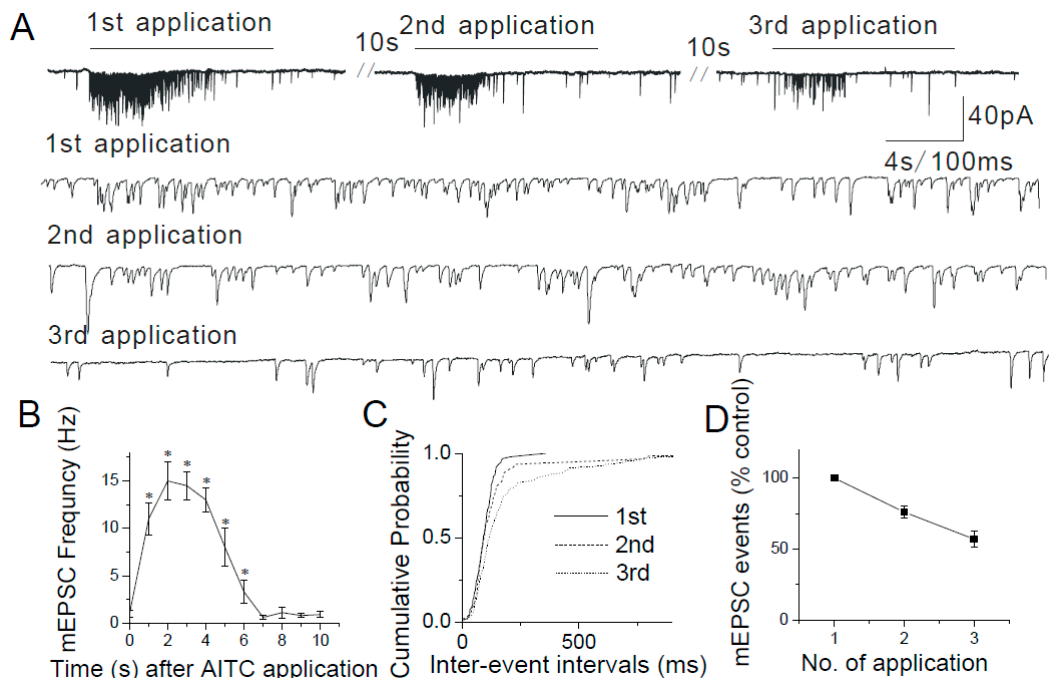
Figure5. ThetachyphylaxisofTRPA1. ( A )AITC(200 µ Figure 5. The tachyphylaxis of TRPA1. ( A ) AITC (200 μ M) causes enhancement of mEPSCs